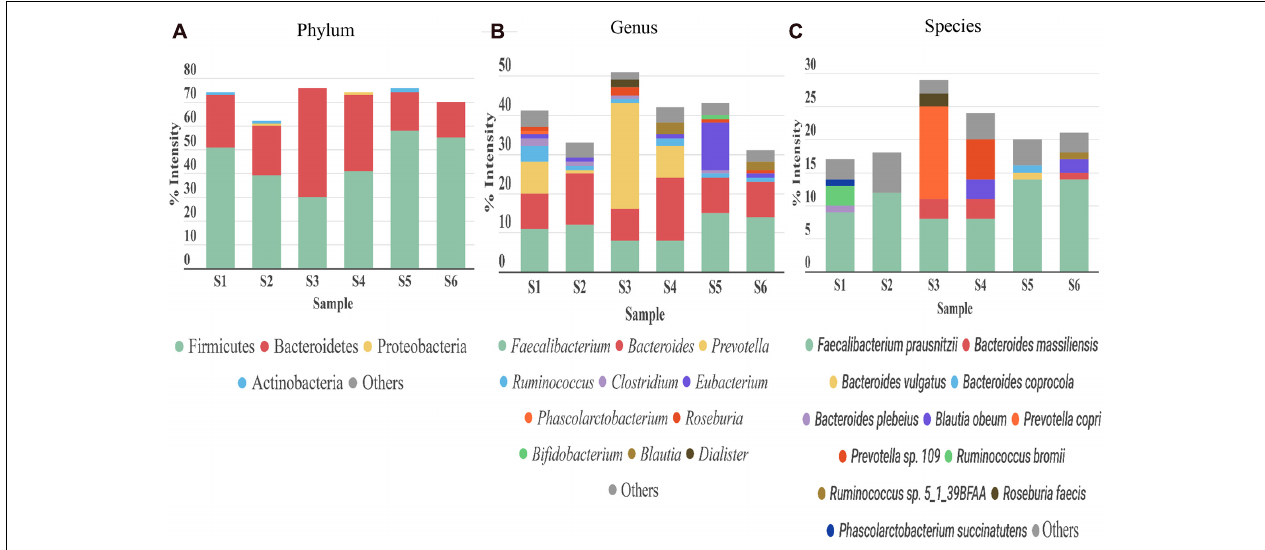
FIGURE 5 | Taxonomic distribution of gut microbiota detected in stool samples from six healthy adults (S1–S6). (A) Phylum, (B) genus, and (C) species levels. Abundance of each phylum/genus/species is correlated to the percentage of peptide intensity ([sum intensity of peptides of the phylum]/[total intensity of sample]). Only those taxon categories with > 1% of abundance are represented in the graphs. The rest are included in the “other”